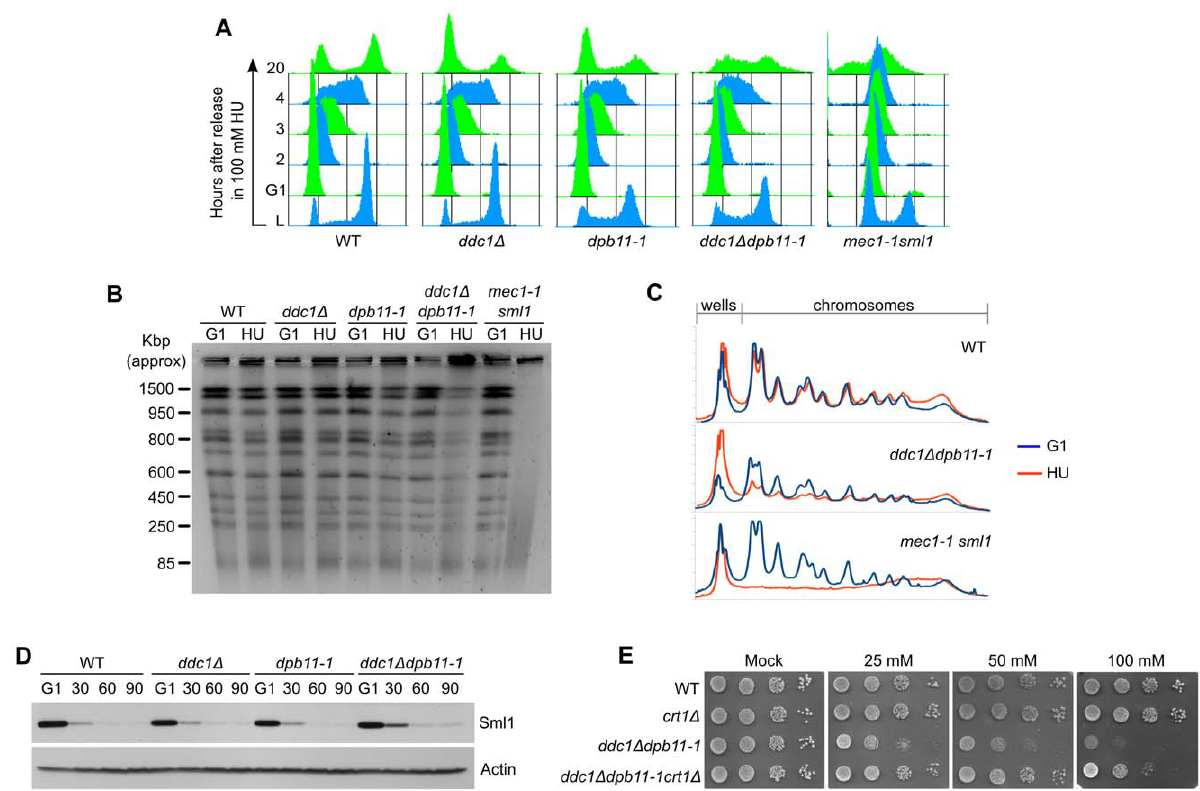
Figure 4. The inability to fully activate Rad53 causes defects in the control of RNR induction. (A) K699 (WT), YFP20 ( dpb11-1 ), YAN21/8d ( ddc1 D ), YFP62/1d ( ddc1 D dpb11-1 ) and YMIC5A3 ( mec1-1 ) were synchronized in G1 with a -factor and released into fresh medium supplemented with 100 mM HU. At the indicated time-points after the release, progression into the cell cycle was monitored by FACS analysis. (B) DNA extracted from the G1-arrested cells and from the cells released for 20 hours in HU was separated by PFGE and stained with ethidium bromide. (C) A plot representing the intensity profile of the significant gel lanes in panel C. (D) K699 (WT), YFP20 ( dpb11-1 ), YAN21/8d ( ddc1 D ) and YFP62/1d ( ddc1 D dpb11-1 ) strains were synchronized in G1 with a -factor and released into fresh medium supplemented with 200 mM HU. At the indicated time- points protein extracts were prepared and probed with a -Sml1 antibodies to measure the levels of Sml1 and with a -actin antibodies as a loading control. (E) Ten fold serial dilutions of overnight cultures of strains K699 (WT), YFP328 ( crt1 D ), YFP62/1d ( ddc1 D dpb11-1 ) and YFP330 ( ddc1 D dpb11- 1crt1 D ) were spotted on YPD plates supplemented with HU at the indicated concentration. Survival was assayed by monitoring cell growth after 6